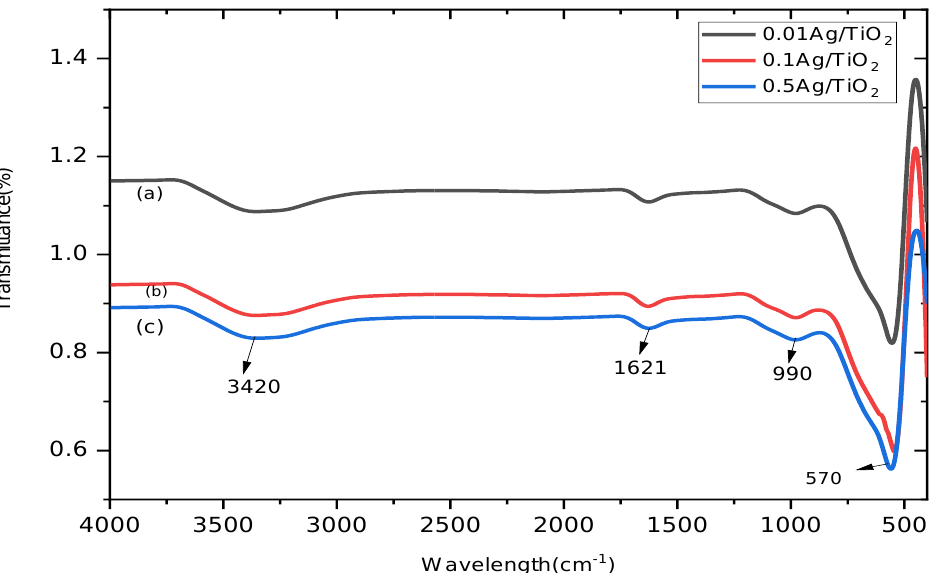
Figure 2. ( a ) FTIR spectrum of 0.01 Ag/TiO 2 composite. ( b ) FTIR spectrum of 0.1 Ag/TiO 2 composite. ( c ) FTIR spectrum of 0.5 Ag/TiO 2 .